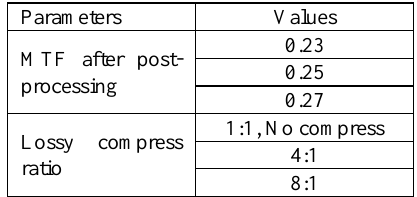
Table 3. Lossy compress and post-processing